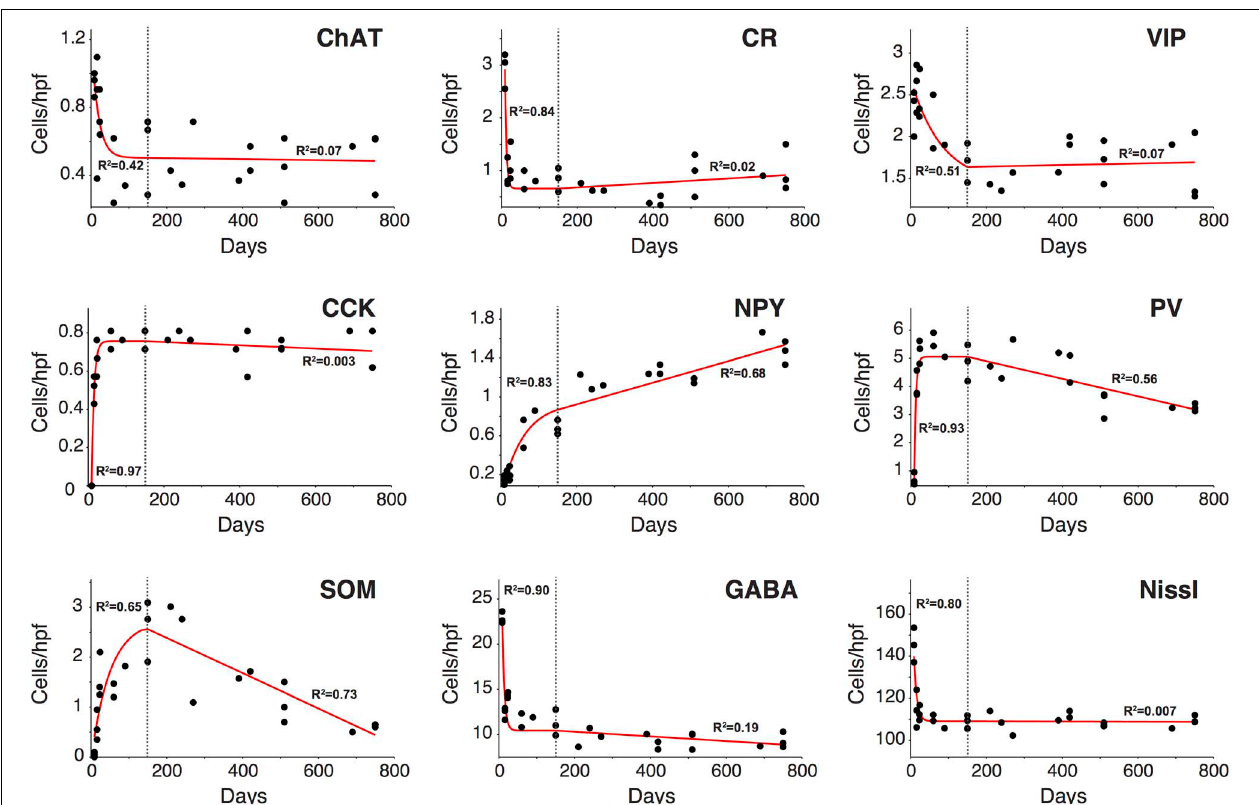
FIGURE 7 | Analysis of the trajectory of the different inhibitory cell markers during the life course. Changes in all cell markers examined between P9 and P150 were best described by an inverse exponential decay or exponential decay function (red line). Most cell markers had reached a plateau by P150 after which point any observed change could be described by a linear